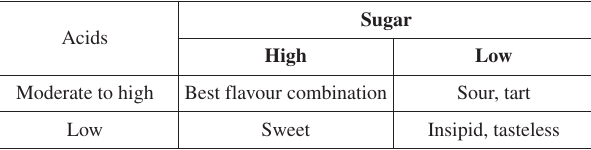
Table 2 The relationship of sugar/acid ratio versus flavour Acids